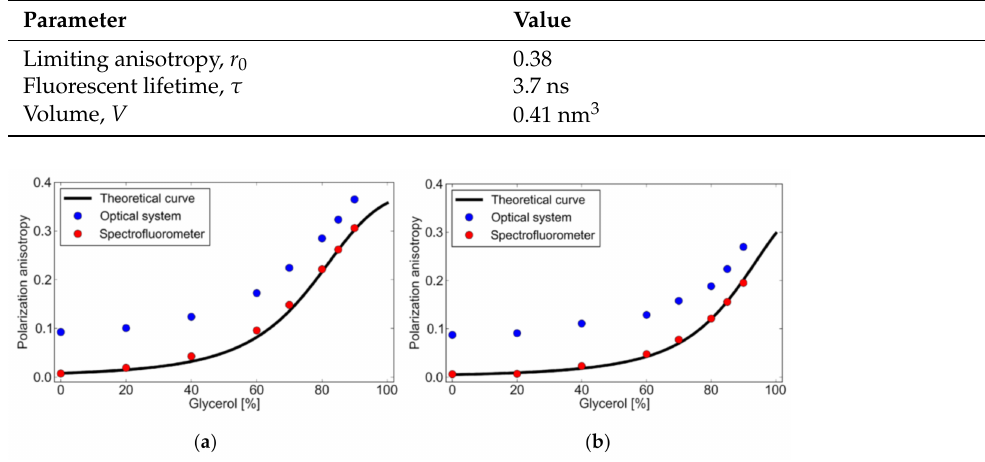
Figure 7. Theoretical and measured fluorescence anisotropy values at ( a ) 30 ◦ C and ( b ) 50 ◦